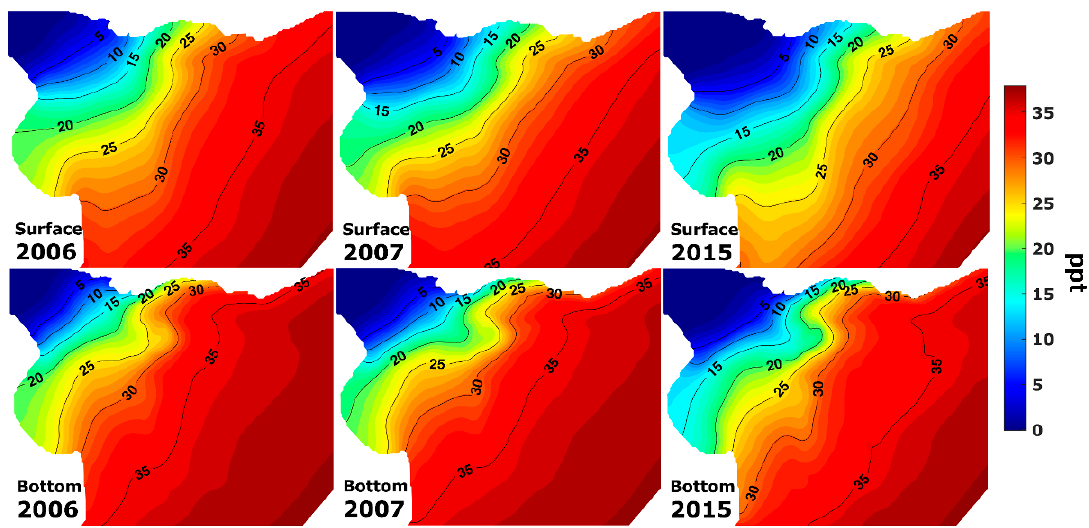
Figure 5. Bottom and surface salinity: annual (ppt) average for the years with lower annual mean fluvial flow (2006), middle annual mean fluvial flow (2007), and higher annual mean fluvial flow (2015). All maps are in geographic coordinates between Lat ( − 36.9, − 34.7) and Long ( − 57.4, 54.2).